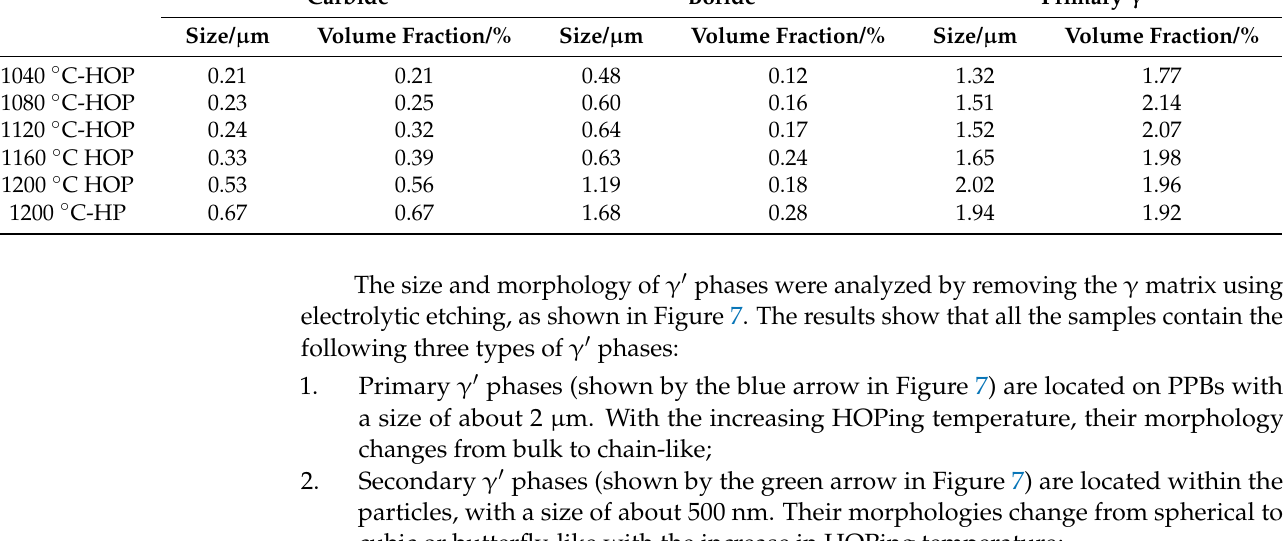
Table 1. The precipitate size and volume fraction of the HOPed and HPed samples.